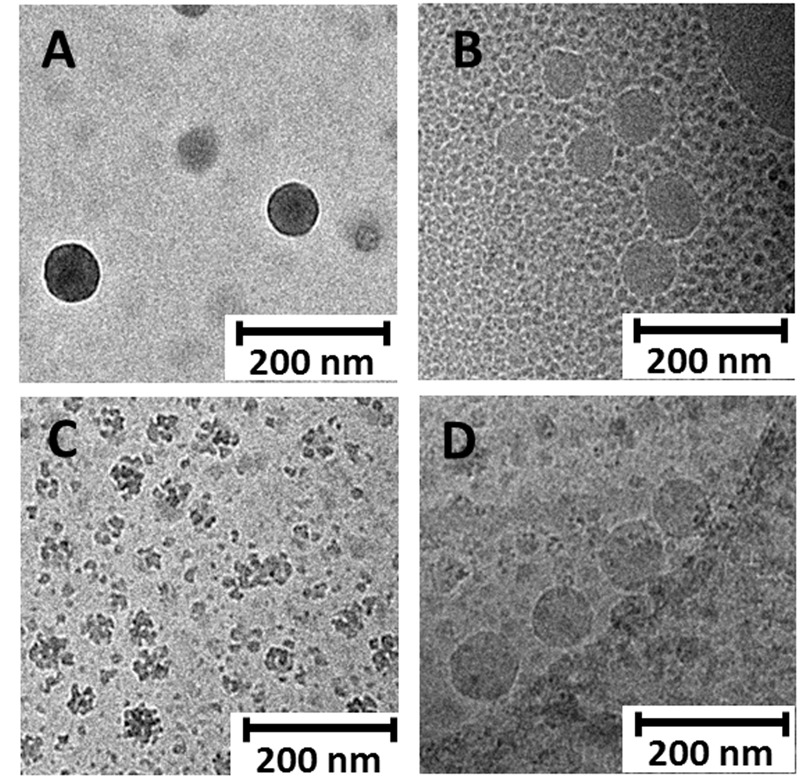
Representative cryo-TEM images of unloaded nanospheres (A) and nanocapsules (B) as well as docetaxel-loaded nanospheres (C) and nanocapsules (D) prepared from heterodimer 1. In the absence of DTX, NS and NC of similar sizes (about 80 nm diameter) are observed (A,B). After DTX-loading, NS size drastically decrease and entities of about 15 nm become observable, which eventually associate to give pomegranate-like aggregates (C). On the contrary, NC size increases after DTX loading to about 150 nm diameter (D). Morphology changes after DTX loading are consistent with alteration of the surface properties of the nanosystems, especially for NS, due to the presence of encapsulated DTX molecules in the peripheral βCD cavities.